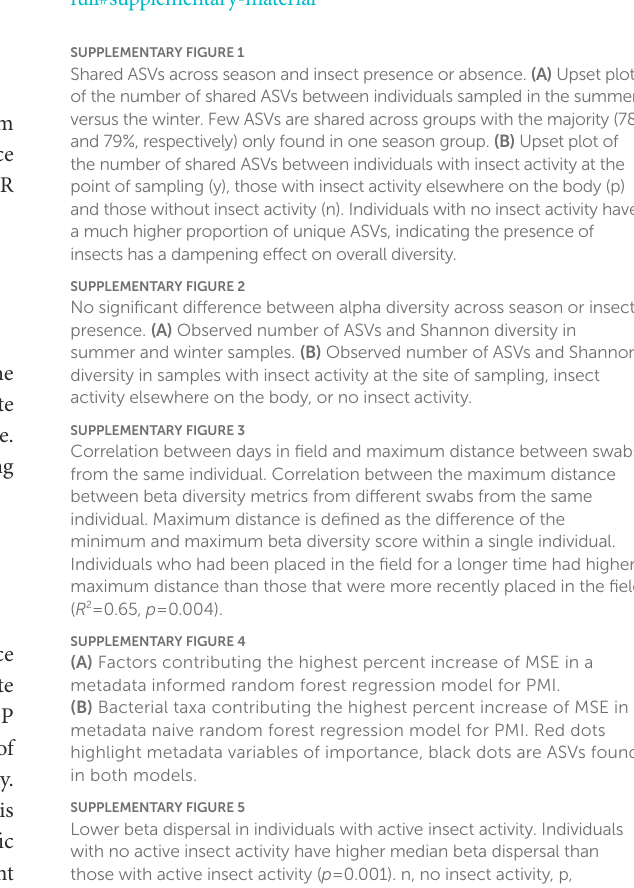
SUPPLEMENTARY FIGURE 4 (A) Factors contributing the highest percent increase of MSE in a metadata informed random forest regression model for PMI. (B) Bacterial taxa contributing the highest percent increase of MSE in a metadata naive random forest regression model for PMI. Red dots highlight metadata variables of importance, black dots are ASVs found in both models. SUPPLEMENTARY FIGURE 5 Lower beta dispersal in individuals with active insect activity. Individuals with no active insect activity have higher median beta dispersal than those with active insect activity ( p = 0.001). n, no insect activity,